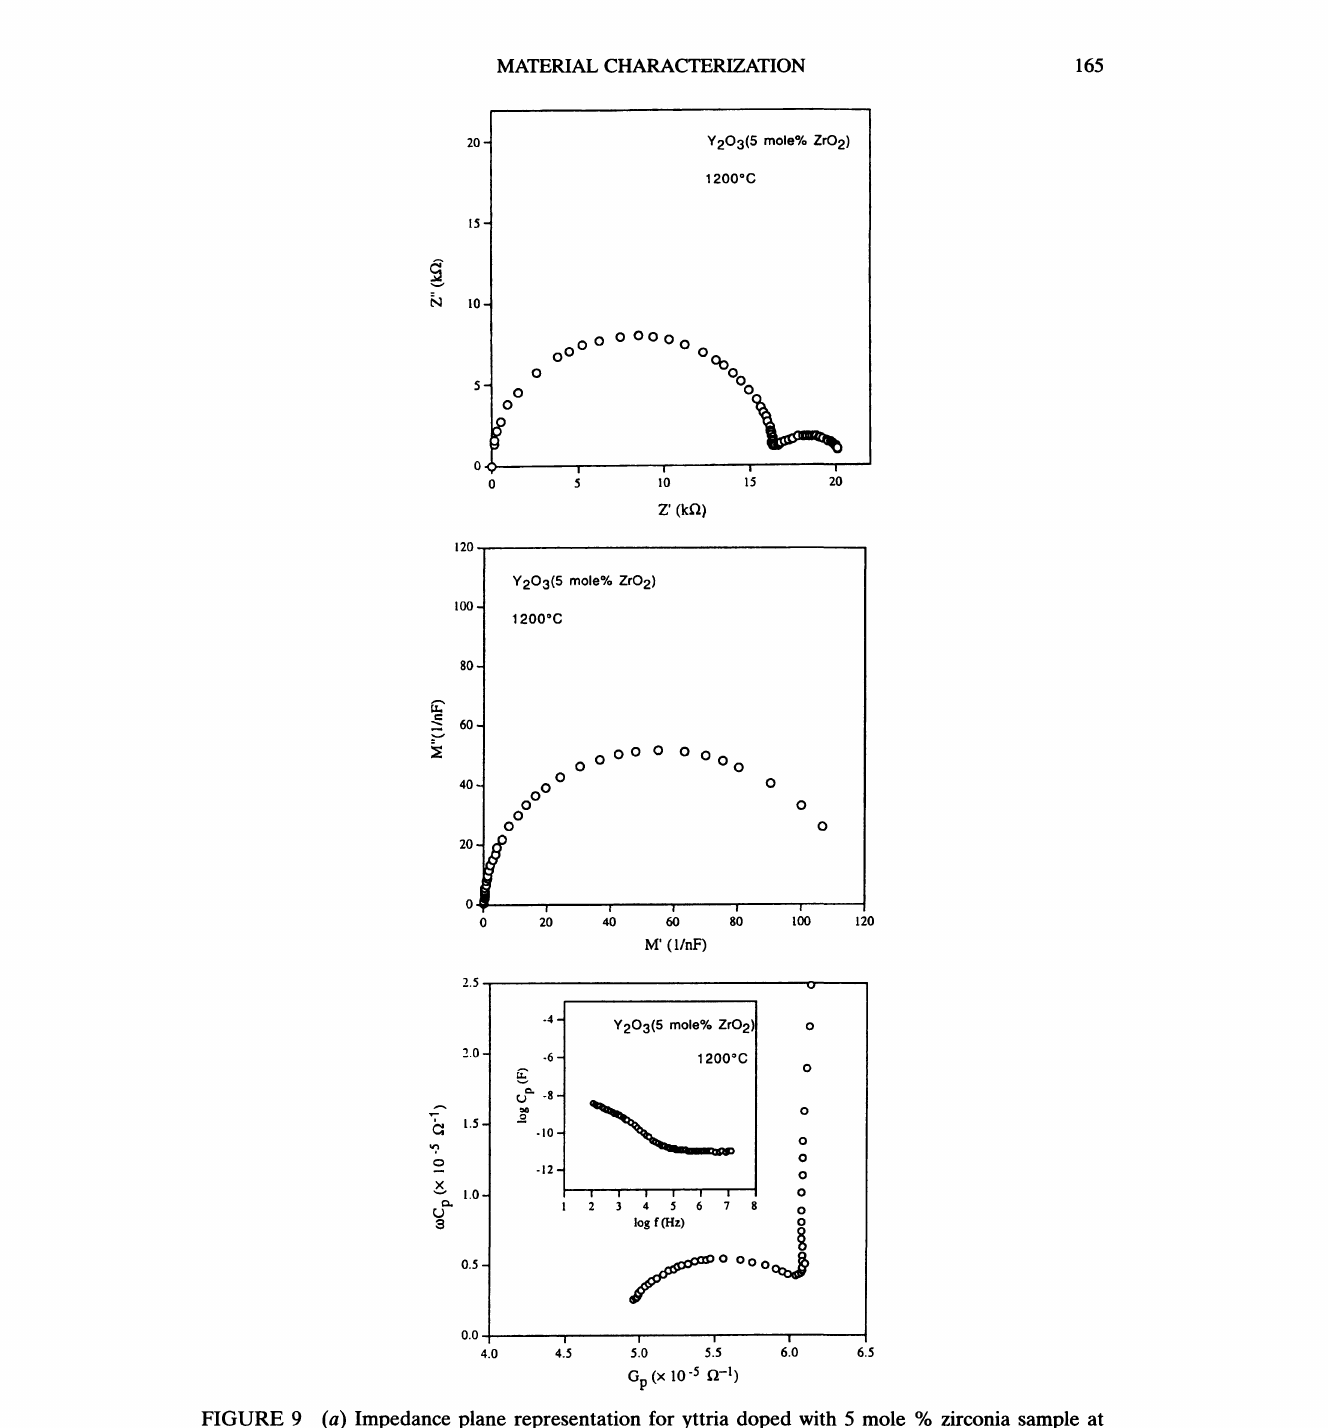
FIGURE 9 (a) Impedance plane representation for yttfia doped th 5 mole % zconia sample at 12*C. (b) Modulus plane representation of the same sample as in (a). (c) Admittance plane representation of the same sample as in (a) or (b). The inset is a Bode plot showing variation of Cp as a function of frequency. The flat region in the high-frequency lit yields a value C which causes vertical representation in